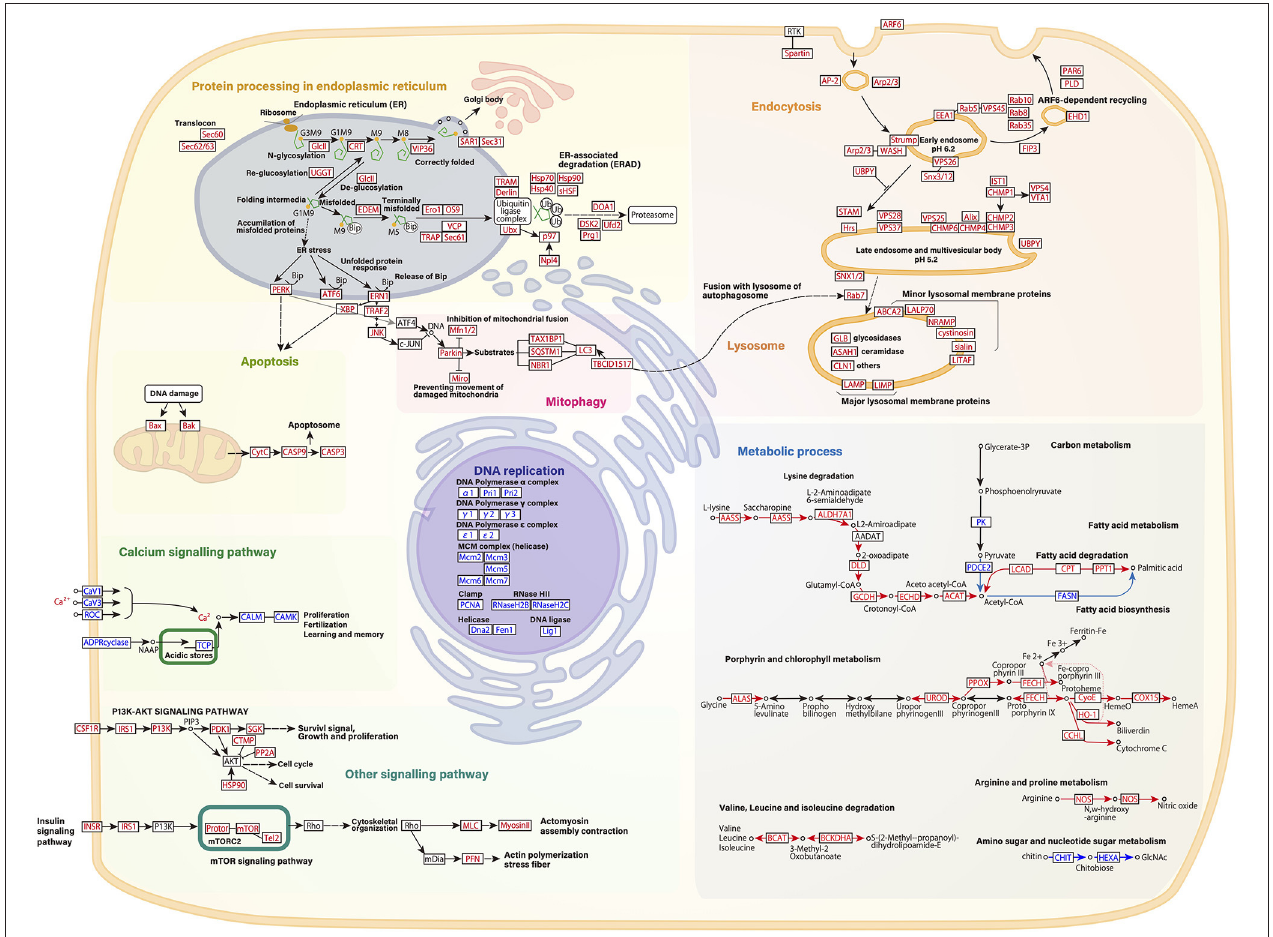
FIGURE 3 | Schematic presentation of several gene pathways involved in high temperature and strong light stress based on RNA-seq data of host corals. Common changes in gene expression between C-coral and D-corals at 31 ◦ C are indicated. Each pathway is described based on the KEGG pathway database (Kanehisa and Goto, 2000). Upregulated transcripts during high temperature and/light stress are shown in red; downregulated transcripts are indicated in blue. Each gene expression pattern is also shown in Supplementary Figure S1 .